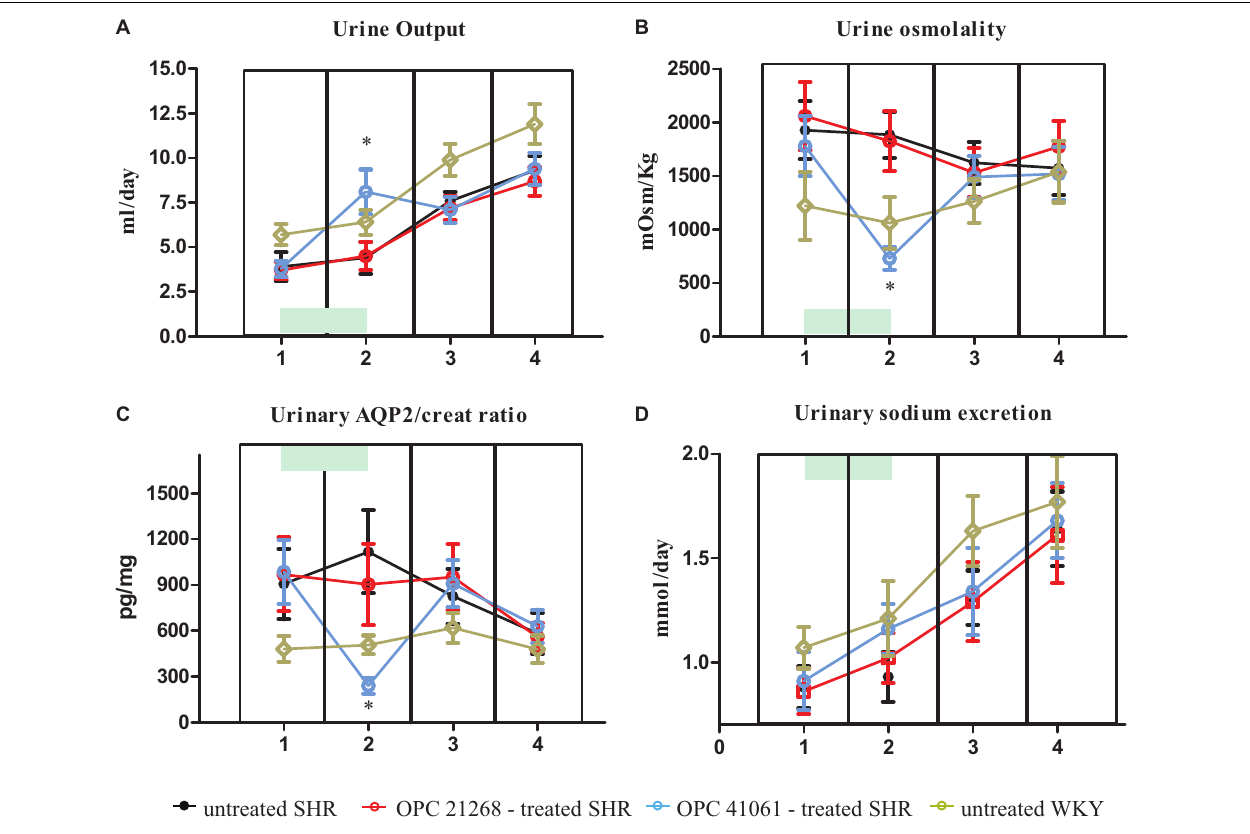
FIGURE 7 | Daily urine output (A) , urine osmolality (B) , urine aquaporin 2/creatinine ratio (C) , daily UNa (D) in untreated SHR ( n = 8, filled black circle), OPC 21268-treated SHR ( n = 10, open red circle), OPC 41061-treated SHR ( n = 10, open blue circle), and untreated WKY ( n = 12, open yellow circle) at 23–25 days of age (period 1: prehypertensive phase, before the initiation of active drug treatment), at 45–49 days of age (period 2: just before the end of active drug treatment), at 96–106 days of age (period 3: stable hypertensive phase in untreated SHR); and at 168–186 days of age (period 4: stable hypertensive phase and organ damage in untreated SHR). Data are expressed as means ± SD. ∗ p < 0.01 of OPC 41061-treated SHR vs. untreated